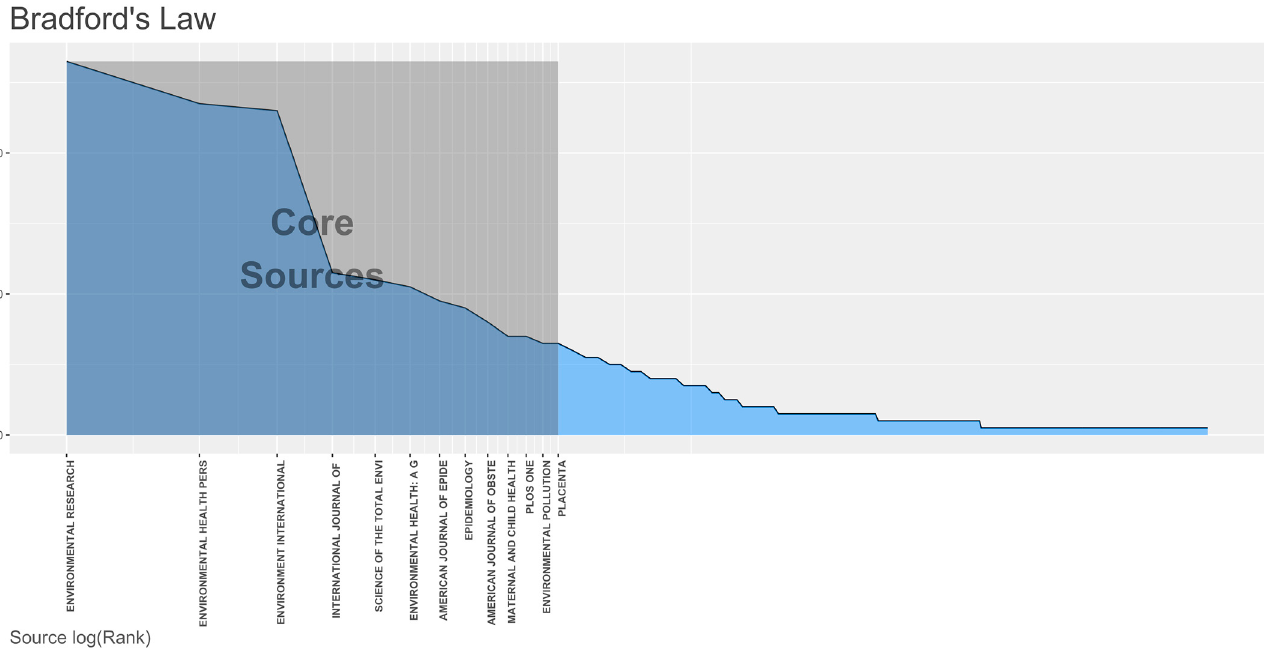
Figure 2. Core sources for publications on environmental toxicants and pollutants and preterm birth. Table 2. Top journals that published regarding environmental toxicants and pollutants and preterm birth.